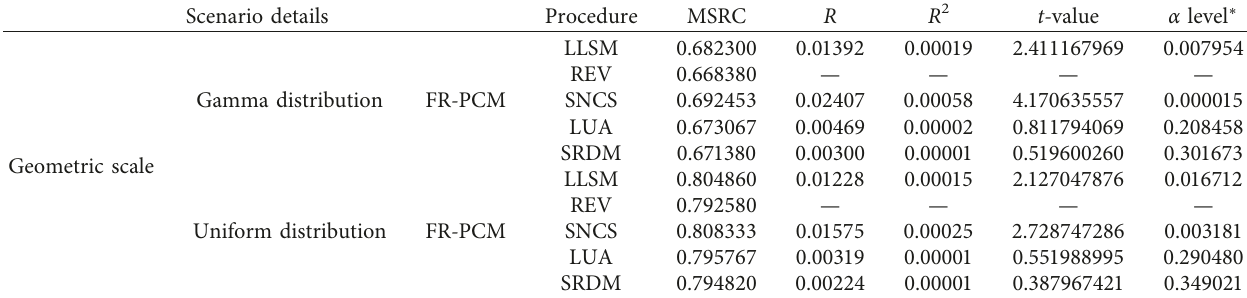
Table 6: MSRC values and principal statistics for the performance test of the REV versus other selected APs. Scenario